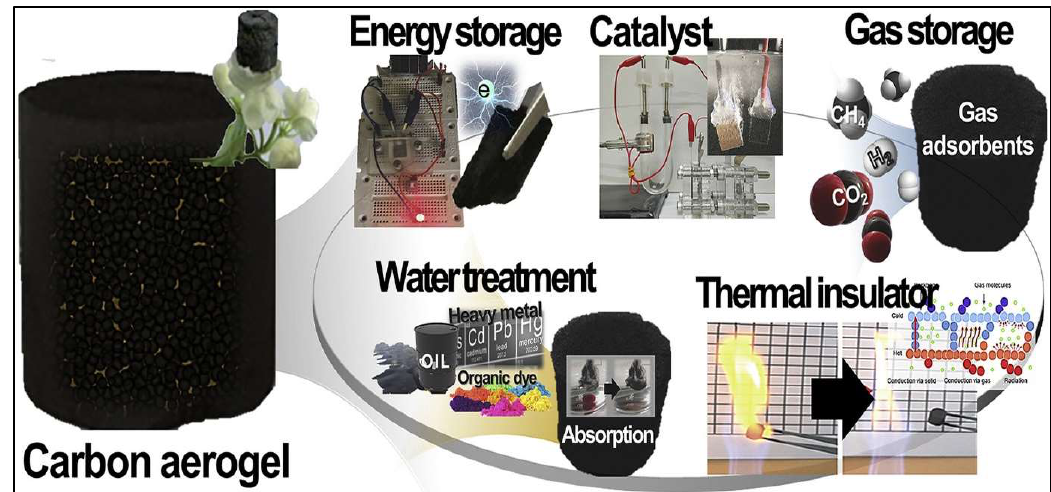
Figure 4. Illustration of carbon and activated carbon aerogel fields with applications. Adapted from [86] .